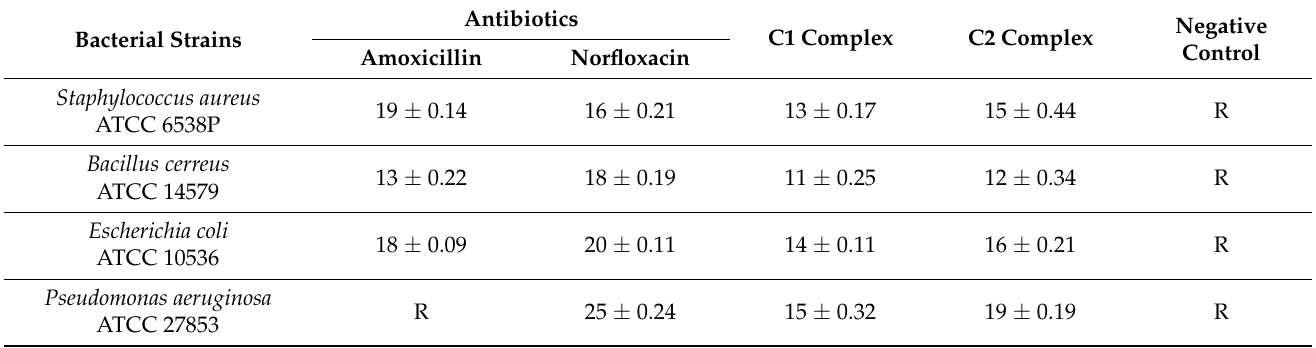
Table 3. Evaluation of the antibacterial activity using the disk diffusion method. Effect of copper complexes on bacterial strains (Halo Zone Test/mm) (mean ± SD) (n = 3). Antibiotics C1 Complex C2 Complex Bacterial Strains